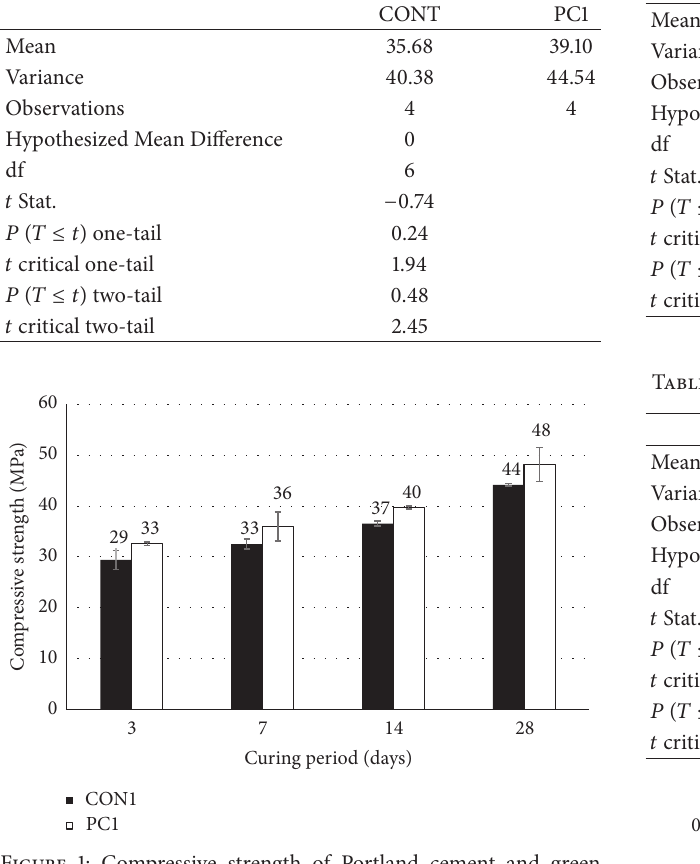
Figure 1: Compressive strength of Portland cement and green cement.